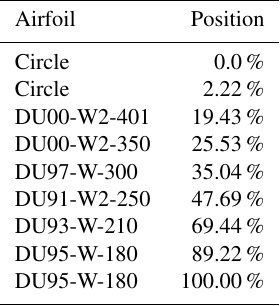
Table 2. Spanwise positioning of the airfoils for the 2.2MW on- shore wind turbine.